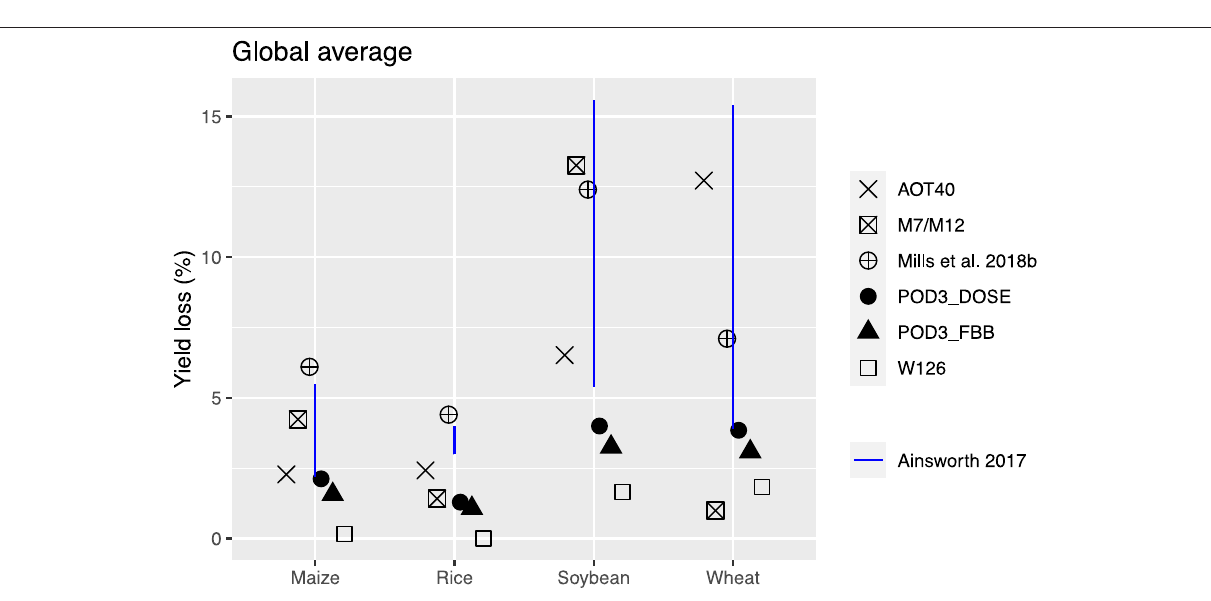
by 21–38% for maize and 36–59% for soybean ( Figure 12